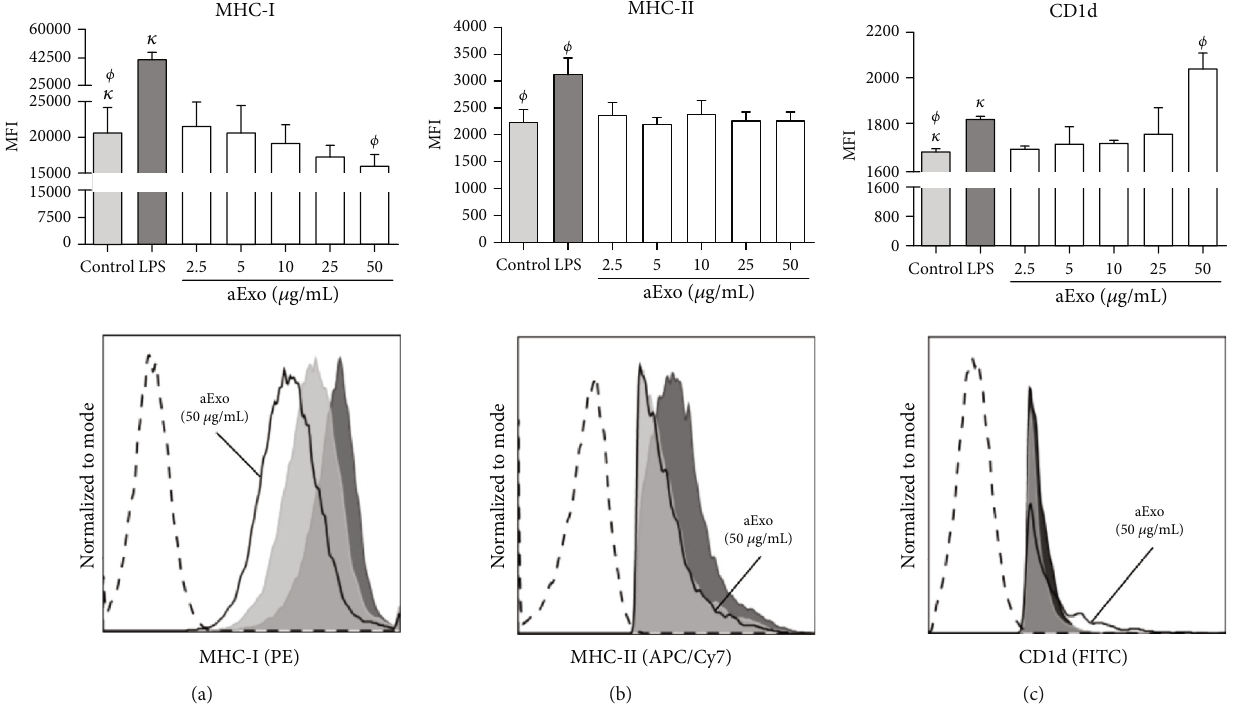
Figure 5: L. mexicana aExo modulate MHC-I and CD1d expression on iBMMs. Infected BMMs were incubated with di ff erent concentrations of aExo (2.5, 5, 10, 25, and 50 μ g/mL) for 24 h. Cells were stained with mAbs anti-MHC-I, anti-MHC-II, and CD1d. (a) MHC-I expression. (b) MCH-II expression. (c) CD1d expression. Nonstimulated iBMMs and positive control of iBMMs incubated with LPS are presented. Top panels exhibit statistical summary bar graphs of mean fluorescence intensity ð MFI Þ ± SD ( n = 5 ). Statistically signi fi cant di ff erences